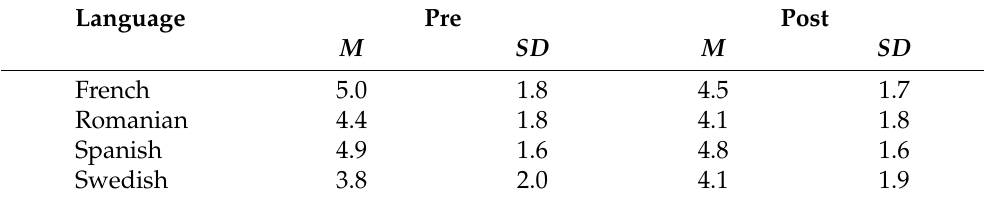
Table A3. I use digital tools (reverse image search, tineye, etc.).